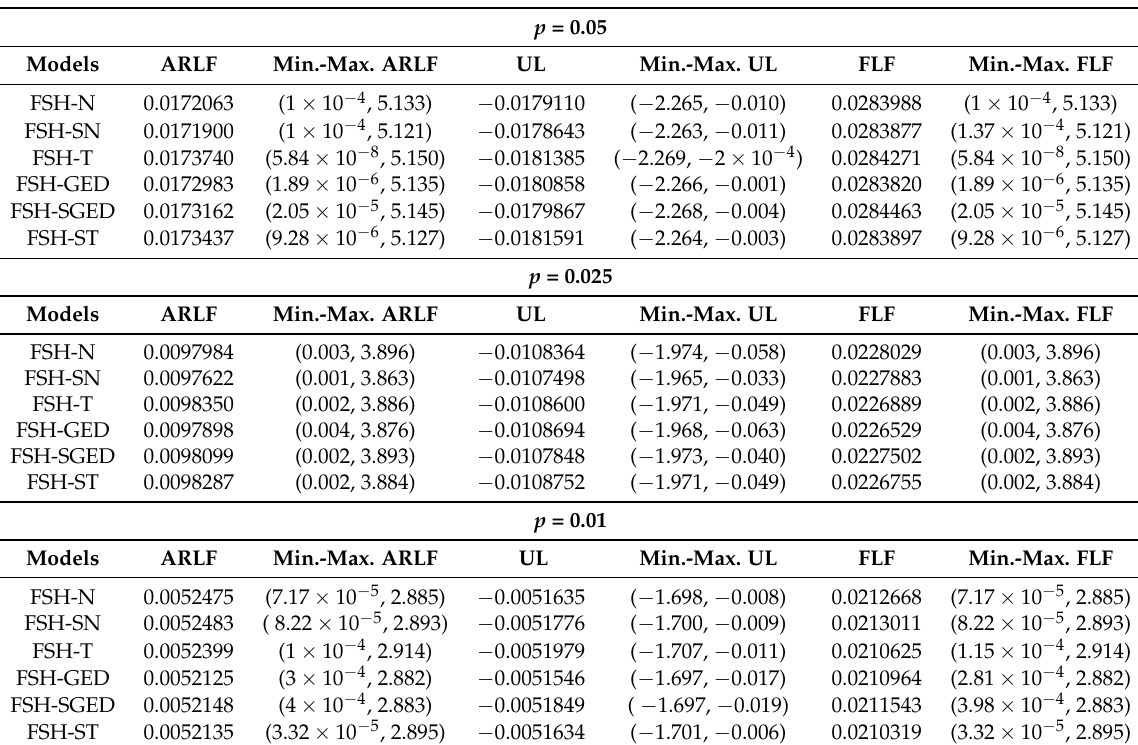
Table 4. Loss functions results of FHS models for long position ( p = 0.05, p = 0.025, and p =